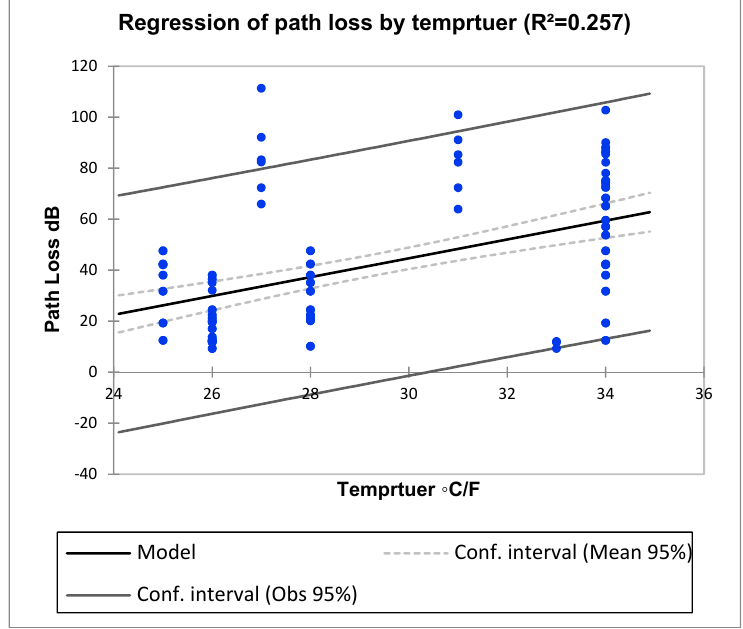
Figure 7. Regression of Path Loss by Temperature.